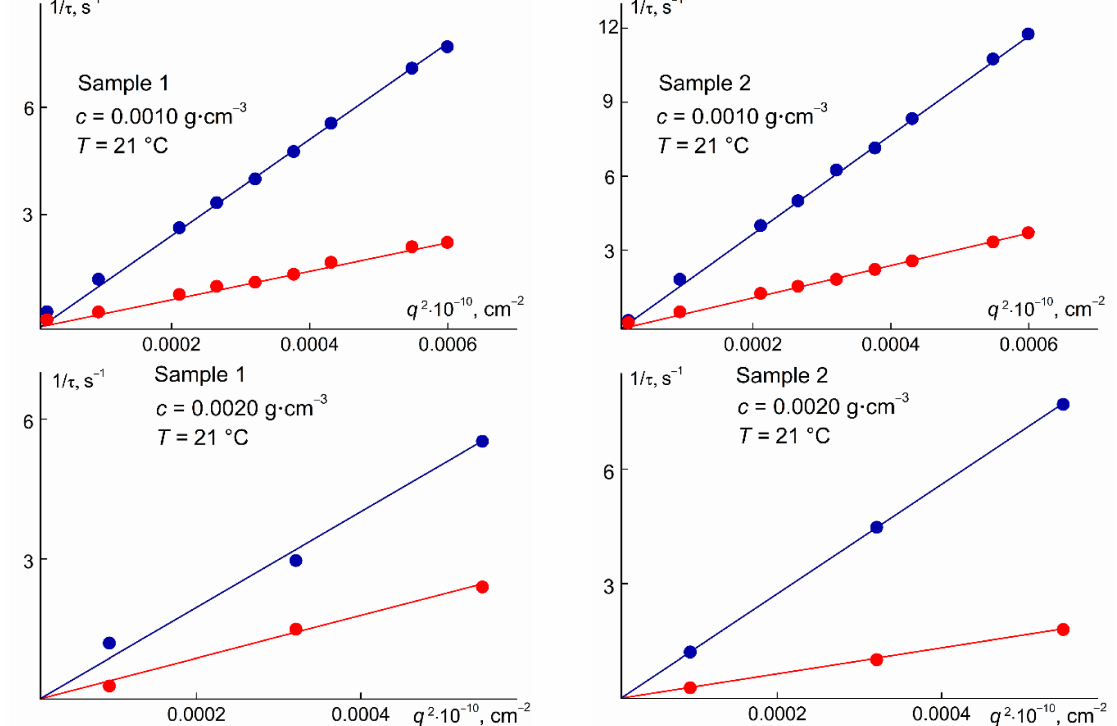
Figure 3. The dependences of the inverse relaxation time 1/ τ on the squared wave vector q 2 for fast (blue symbols) and slow modes (red symbols) for solutions of PDMS- g